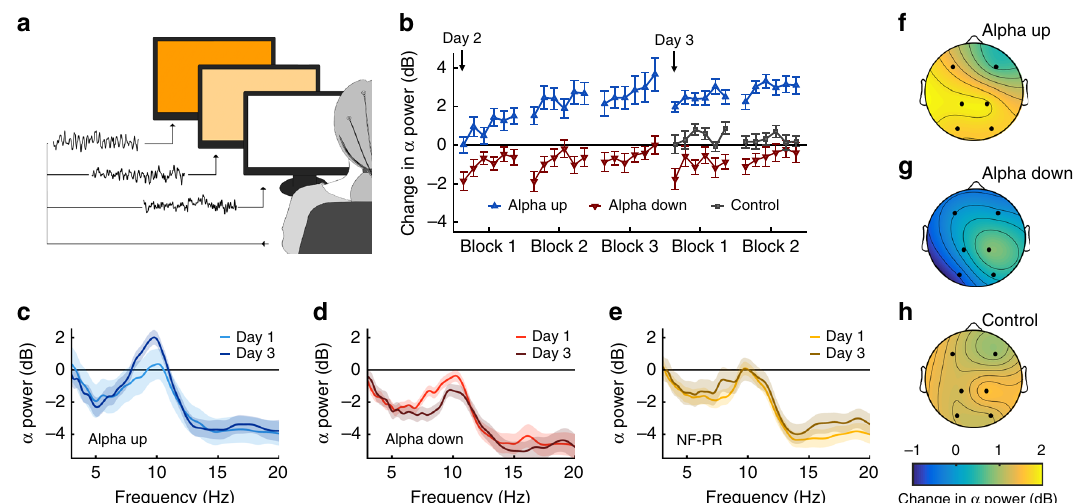
Fig. 1 Effects of the neurofeedback (NF) protocol on somatosensory alpha power. a Illustration of the color-coded real-time visual feedback provided to participants. The screen transiently changes color depending on the amount of alpha power changes over CP1 (deep orange visualized a 10 mV change of alpha power, which could be either an increase or a decrease dependent on the respective NF-group). Shown here is an example for the alpha up group. b Time course of alpha power changes on both training days, relative to the fi rst baseline measure on day one (0 dB), revealing considerable training effects. Data are presented as mean ± SEM (standard error of the mean). Each data point represents a 1-min NF training phase. c – e Comparison of alpha power spectra between the fi rst baseline on day one and the end of the NF training (power values without baseline normalization) for the alpha up group ( c ) the alpha down group ( d ) and NF-paradoxical-responder (NF-PR; e ) revealing a clear distinction between groups. Data are presented as mean ± SEM. f – h Spectral changes in the alpha peak frequency during NF training on day three, interpolated from the measured electrodes over the scalp for the alpha up ( f ) the alpha down ( g ) and the control ( h ) group (alpha up: n = 17; alpha down: n = 15; control: n = 20; NF-PR: n =